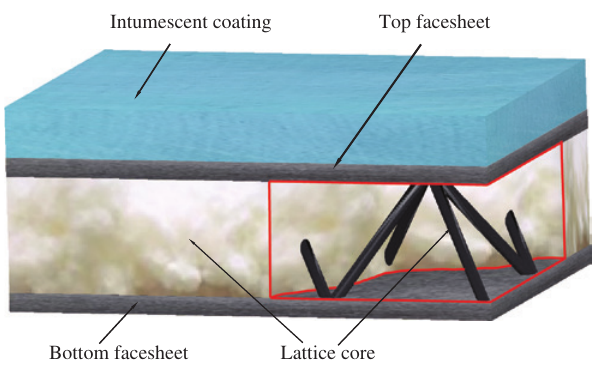
Figure 1: Schematic of the fire-proofing composite lattice sandwich